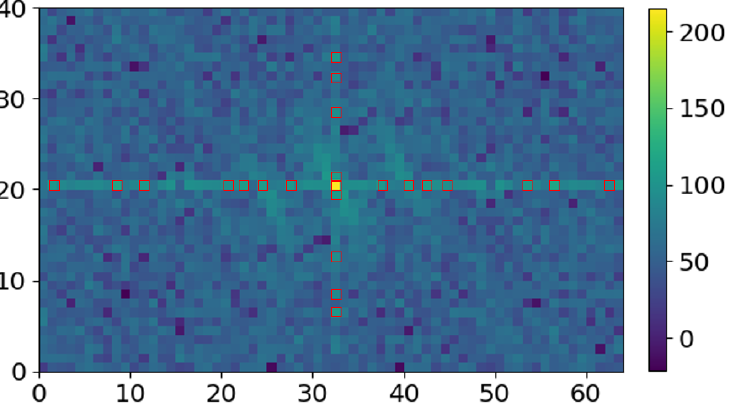
Figure 7. The 2D power spectrum with prominent symmetric peaks on central horizontal and vertical stripes highlighted with red color edges, corresponding to the vertical and horizontal periodic noise on the 2D spatiotemporal maps,